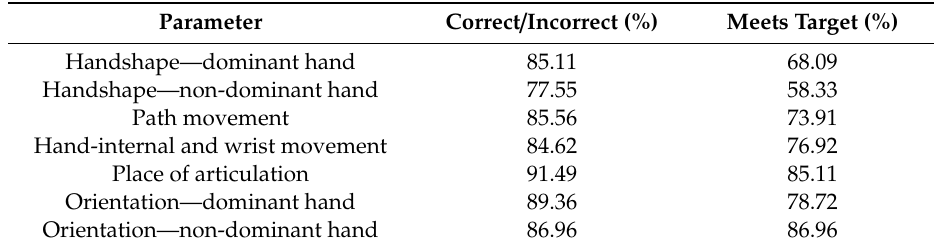
Table 1. ASL-SRT percent correct for phonological